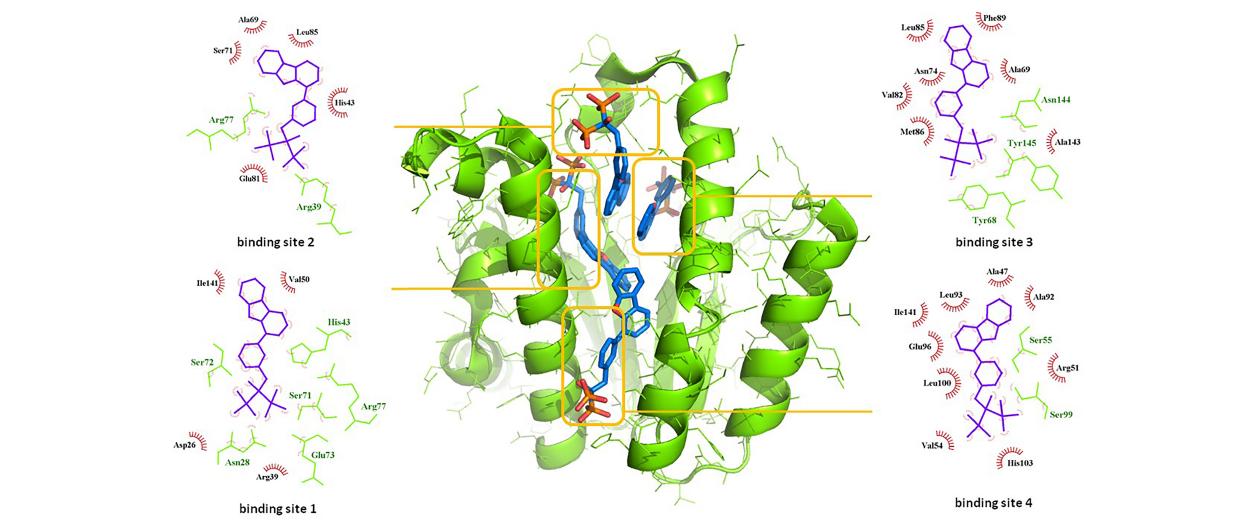
FIGURE 1 | Binding sites of co-crystalised bisphosphonate inhibitor (depicted in blue stick model; BPH-629) in E. coli UppS (presented as a green-colored ribbon model; PDB ID: 2E98). Four observed binding sites (emphasized) are presented with small-molecule inhibitor in blue, amino acid residues forming polar contacts in green with residues that form lipophilic interactions in red.